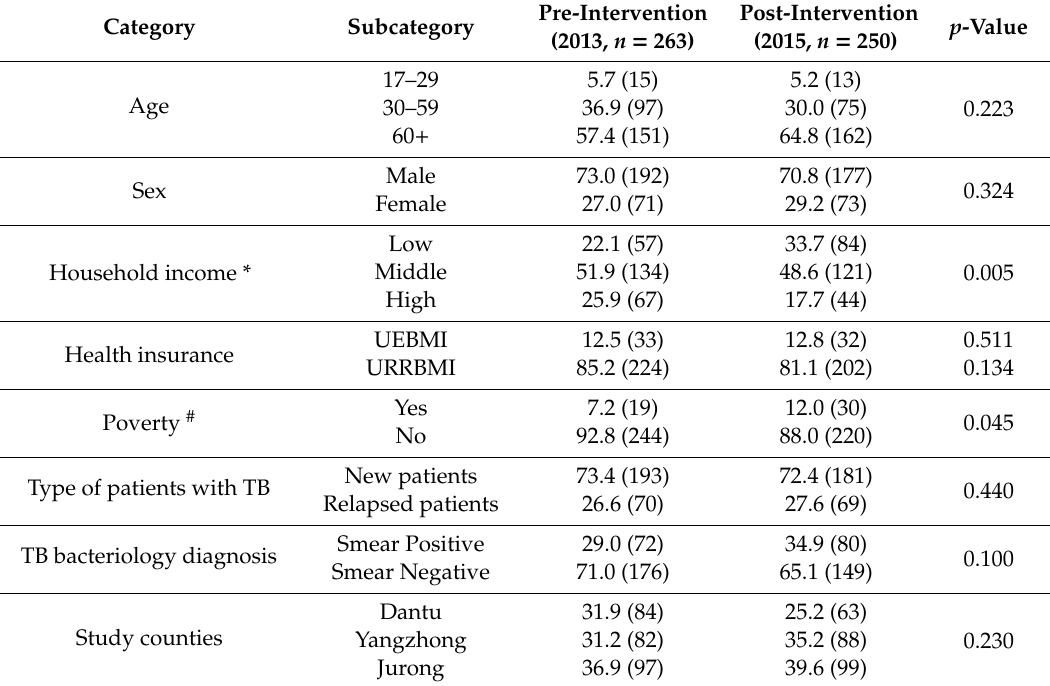
Table 2. TB patient characteristics in the pre- and post-intervention surveys in Zhenjiang, in 2013 and 2015, % ( n